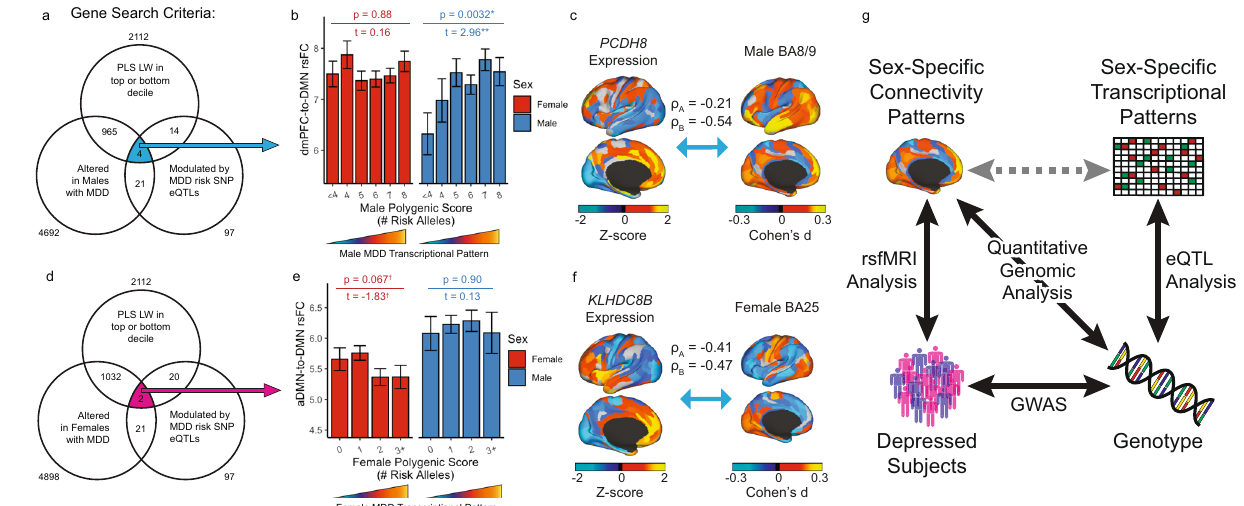
Fig. 5 | Validating model predictions: inferred expression levels of depression- related genes predicted individual differences in DMN connectivity. a Schematic for identifying genes with convergent evidence of abnormal expres- sion in an RNA-seq analysis 8 (lower left circle), expression regulated by GWAS- con fi rmedriskvariants(lowerrightcircle),andimplicatedbyourmaleBA8/9PLS-R model (top circle). Four genes met all three criteria: PCDH8 , PRSS16, MRM2 , and ZKSCAN8P1 . b Association between individual differences in DMN-to-dmPFC con- nectivity in n =1458 UK Biobank subjects ( n =537 males) with a history of depres- sion and individual differences inpolygenicdepressionrisk at fi ve MDDrisk